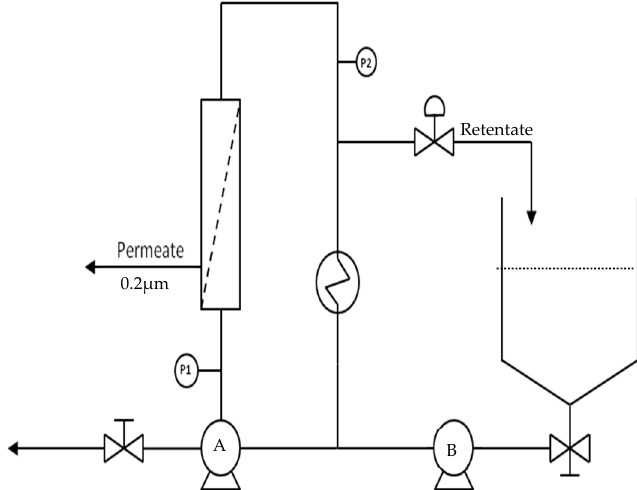
Figure 1. Diagram of microfiltration membrane filtration modified from Gerardo et al, 2015 [27]. P1 and P2—pressure gauges; A and B—centrifugal pumps.